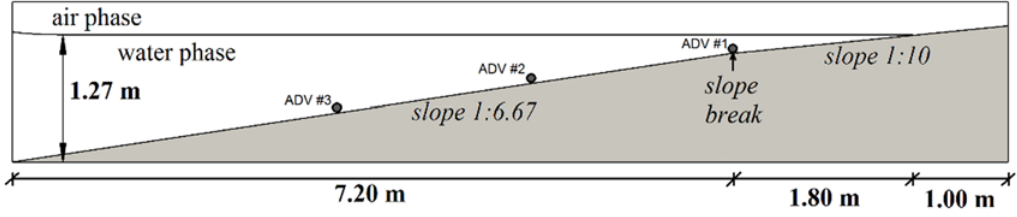
Figure 5. Computational domain for numerical modeling, with the initial water surface.